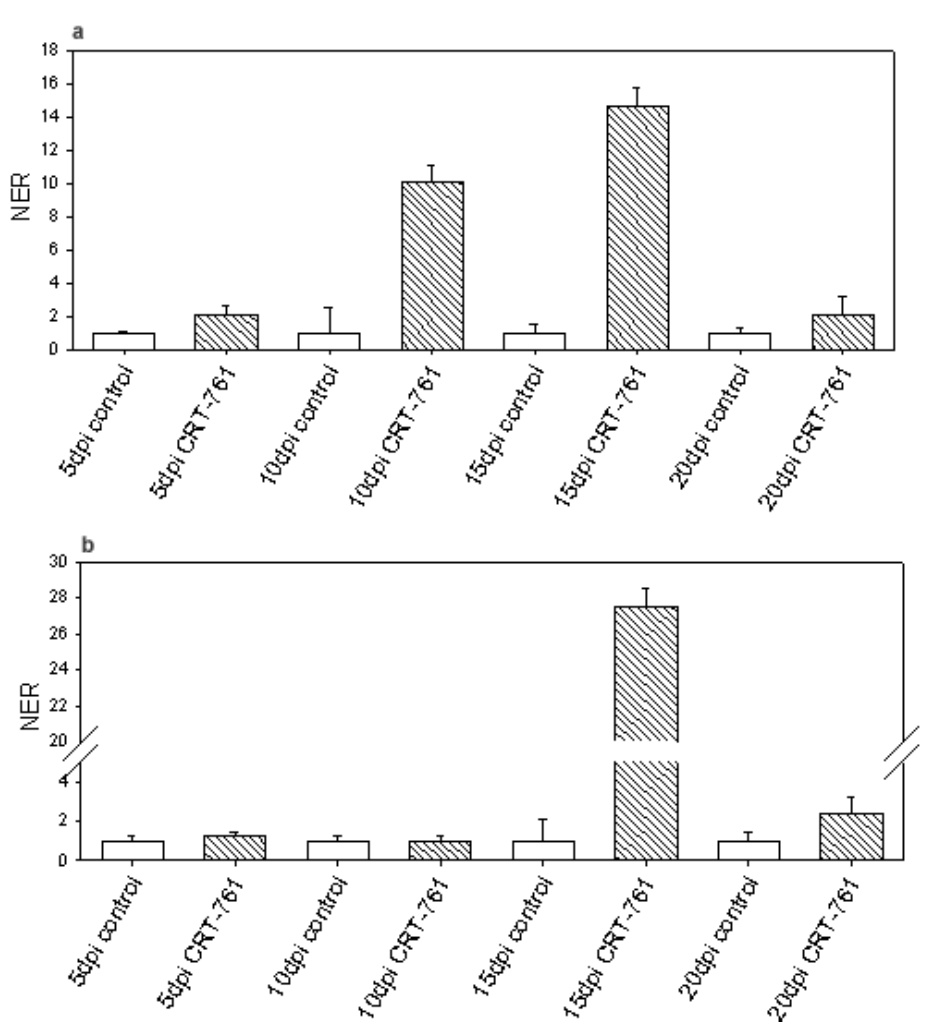
Figure 5. Mi-CRT transcript level in parasitic stages. Normalized expression rate (NER) of Mi-CRT at 5, 10, 15 and 20 days post infection (dpi). White bars represent Mi-CRT transcript levels in nematodes soaked in control siRNA. Striped bars represent Mi-CRT transcript levels in nematodes soaked in siRNA CRT-761 before inoculation. ( a ) J2s were soaked for 1 hour in siRNA in water, washed and incubated for 16 hours in water before infection; ( b ) J2s were soaked for 1 hour in siRNA in the presence of 3% lipofectamine and 25 mM glutamate, washed and incubated for 16 hours in water before infection. For each time point, the results are from two independent biological replicates, each with three RNA extractions. Error bars: Standard error of the mean